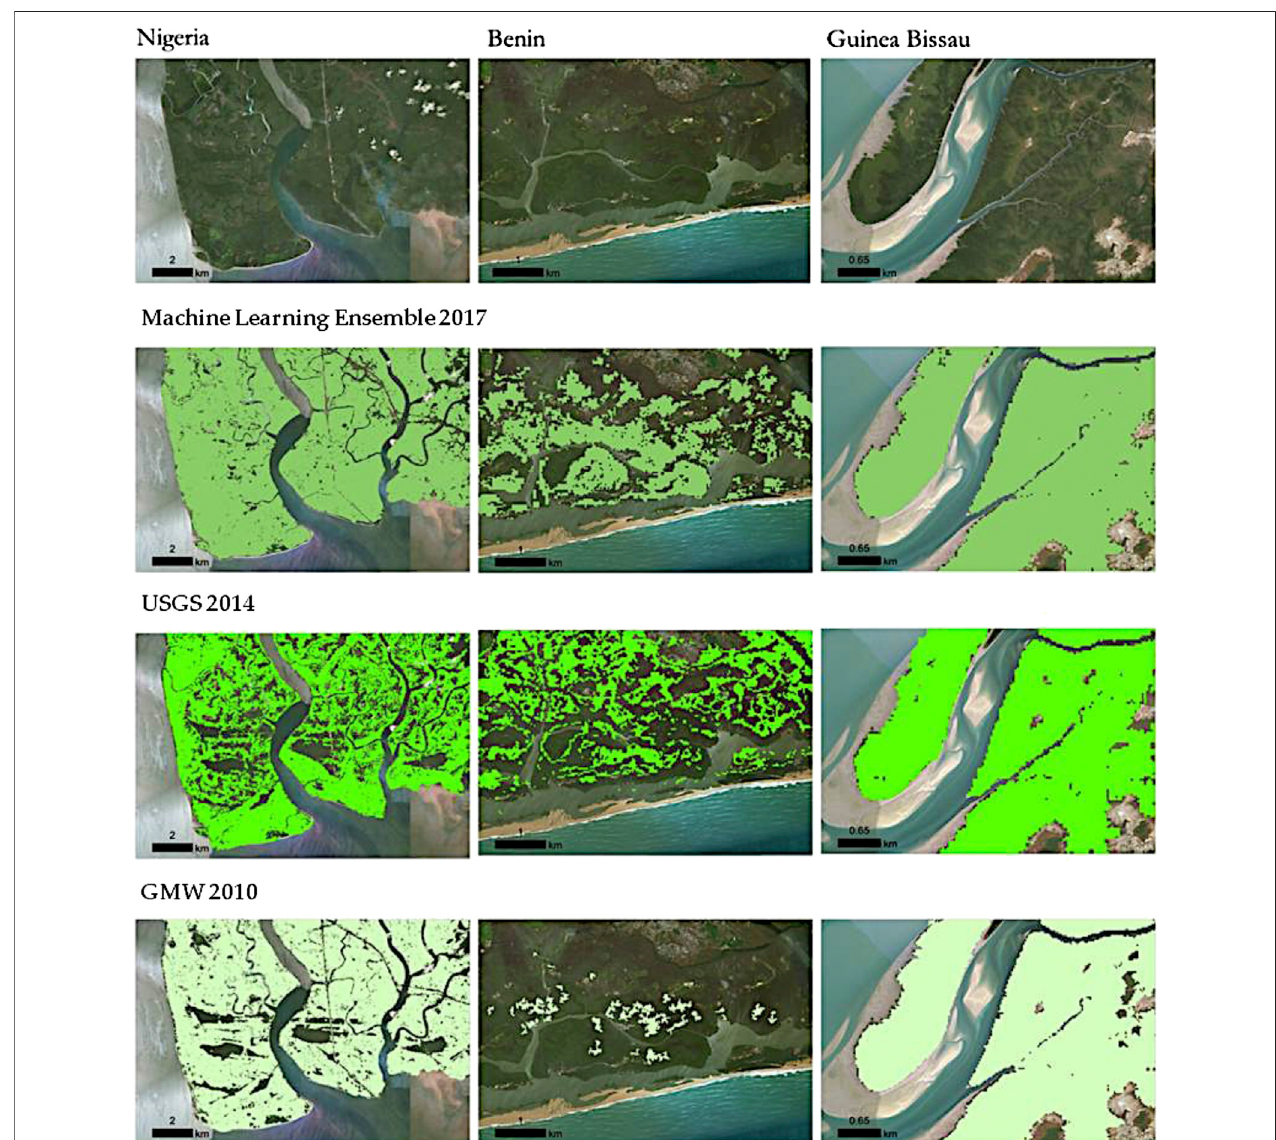
FIGURE 4 | Illustration for the comparison of mangrove extent data products from our machine learning ensemble 2017, USGS 2014, and GMW 2010. It reveals that in general, our mangrove extent map is highly consistent with the spatial distribution patterns of mangrove forests identi fi ed by both USGS 2014 and GMW 2010 (Nigeria and Guinea Bissau), and ours performs better (relative to the USGS 2014) when they are not consistent by checking the details against fi ne resolution imagery (Benin).